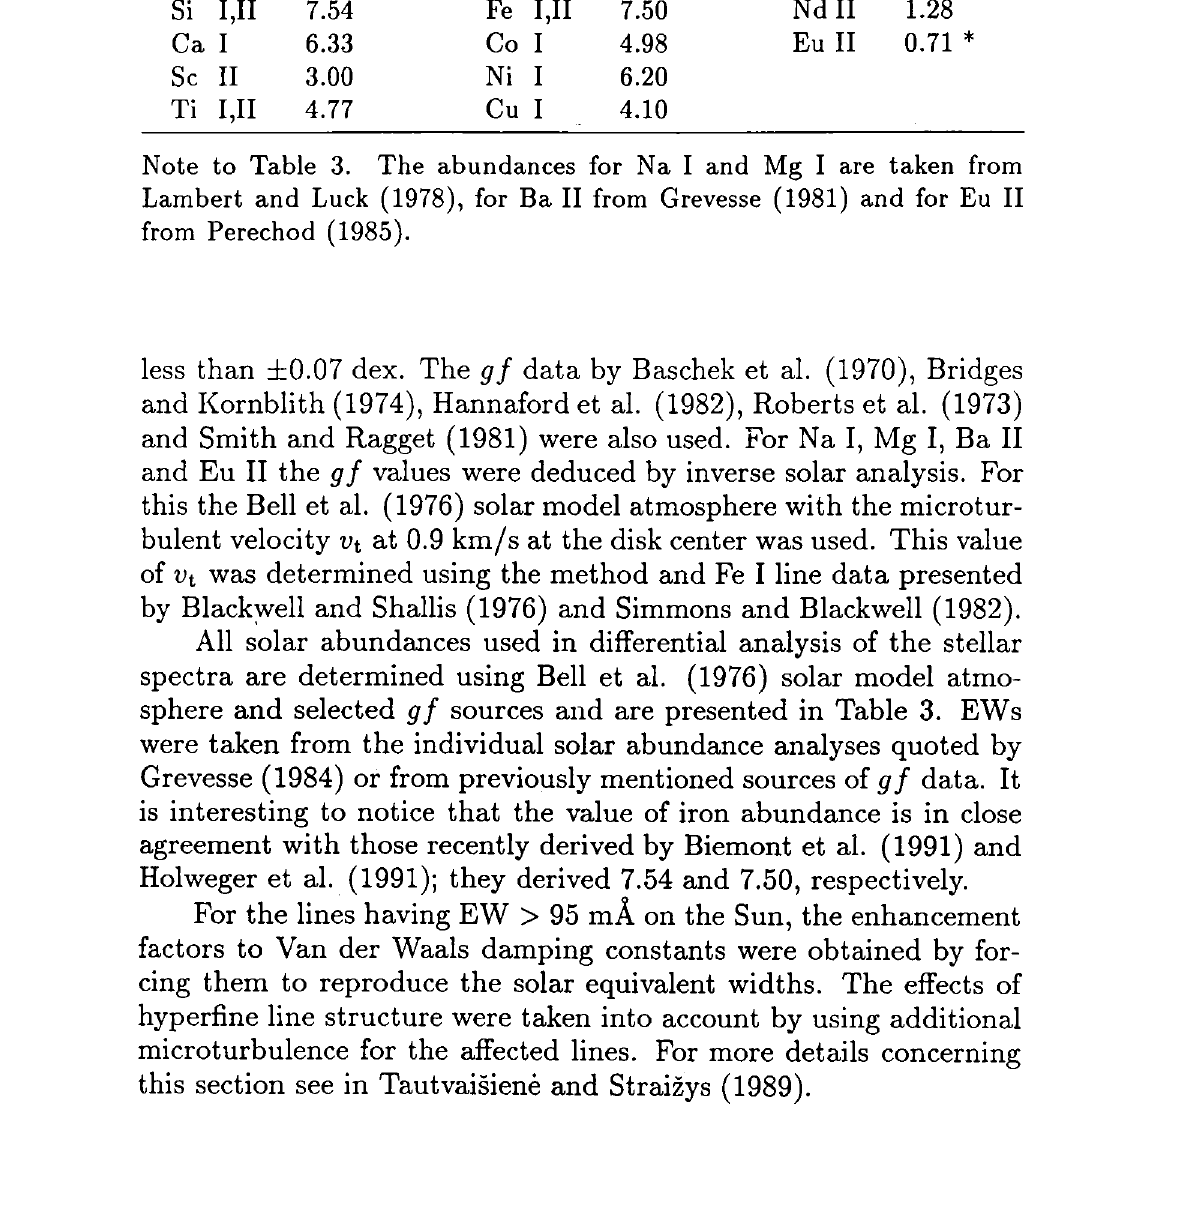
Table 3. Solar abundances obtained with the Bell et al. (1976) model